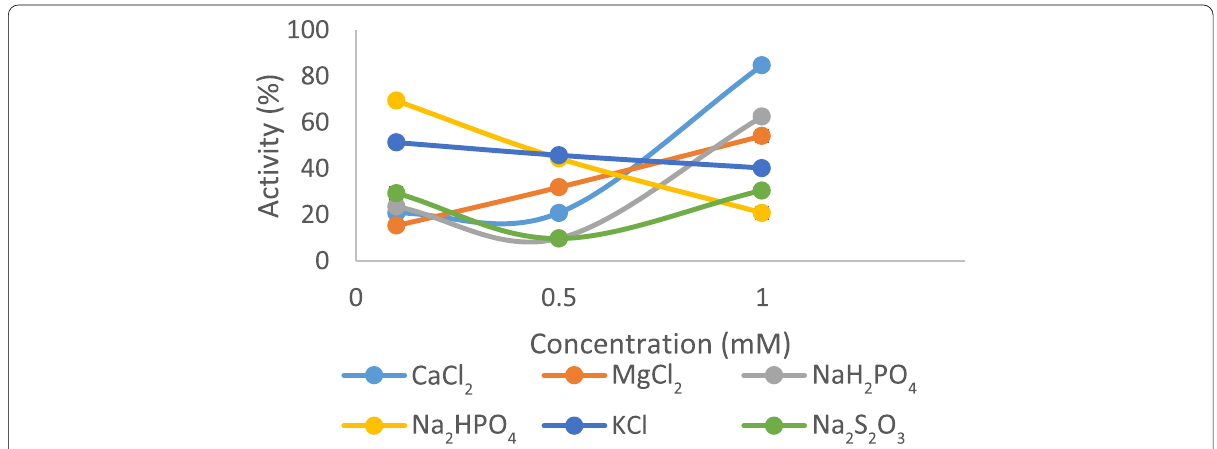
Fig. 4 Effect of different concentrations of some compounds on amylase activity from P. tuberregium